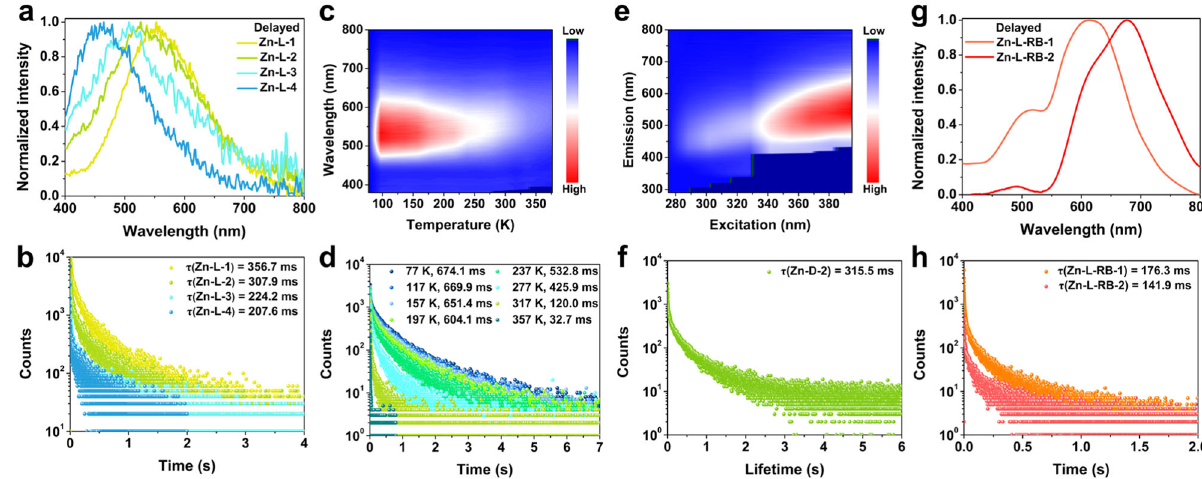
Fig.4|PhotophysicalpropertiesofZn – LSGsandRBdopedSGs.a , b DelayedPL spectra and lifetime pro fi les of Zn – L-1/2/3/4 SGs excited by 365nm at room tem- perature. c , d Delayed PL mapping spectra and lifetime pro fi les of Zn – L-2 SG excited by 365nm at different temperatures. e Delayed PL spectra of Zn – L-2 SG